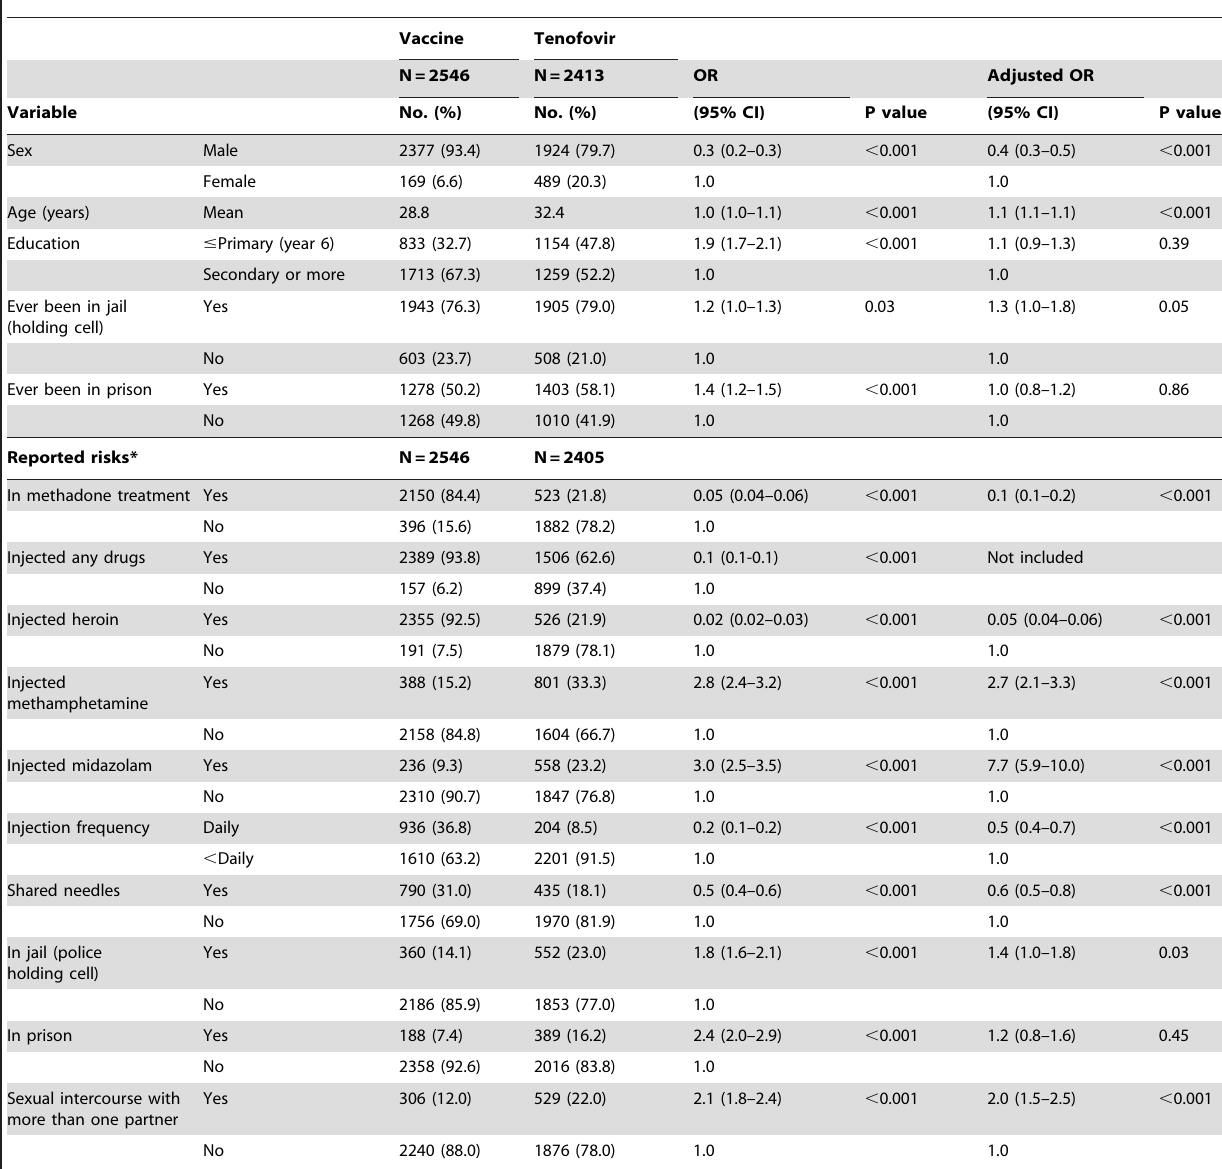
Table 2. Results of bivariate and multivariate analysis comparing baseline demographic characteristics and risk activities reported by injection drug users participating in the 1999–2003 AIDSVAX B/E Vaccine Trial and the ongoing Bangkok Tenofovir Study,